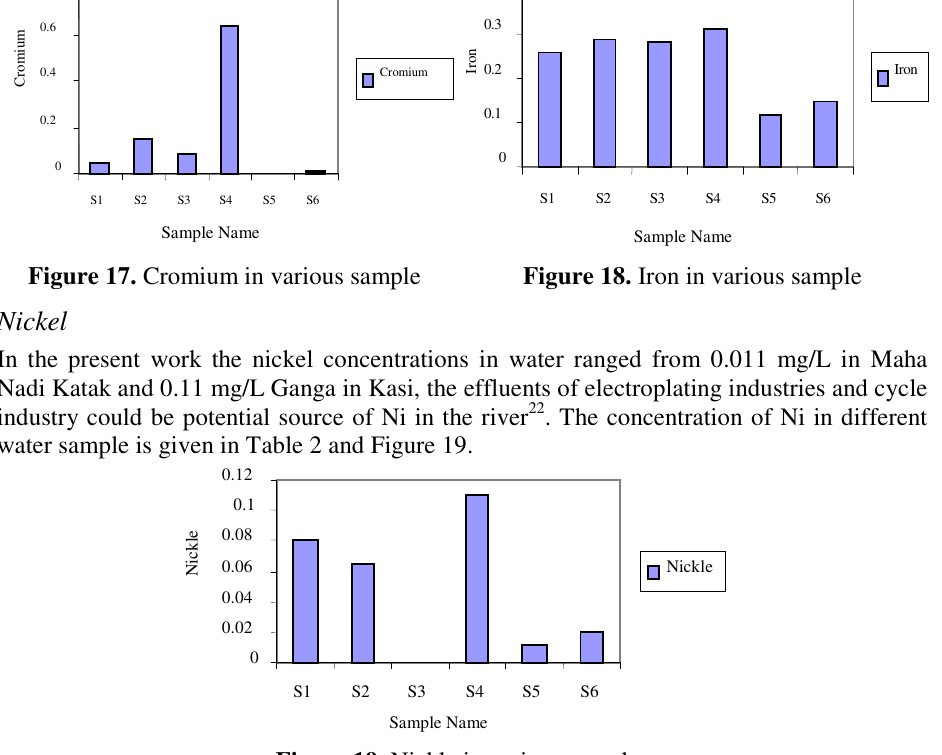
Figure 19 . Nickle in various